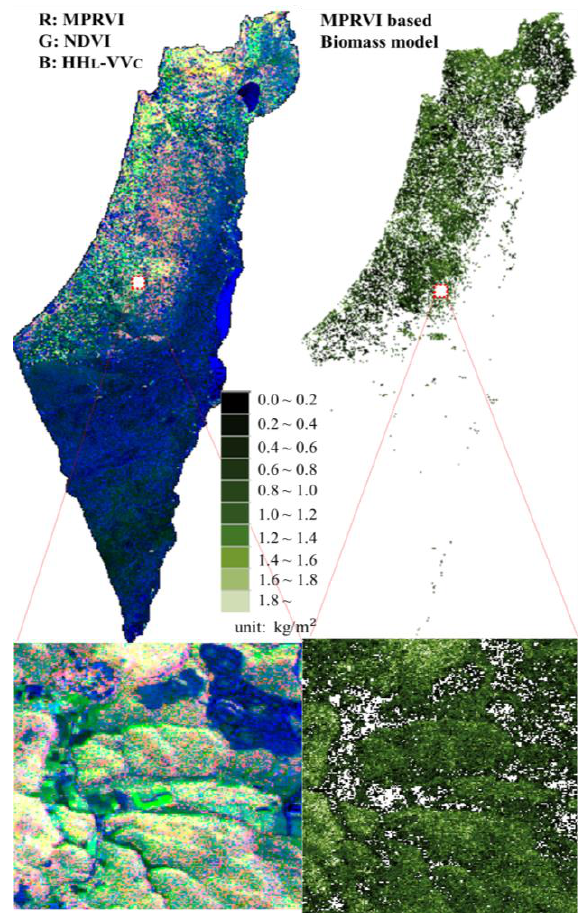
Figure 4 . (Left) RGB image (R: MPRVI, Green: NDVI, Blue: HH L – VV C ) with the enlarged area of Ella Valley, and (Right) MPRVI-based biomass